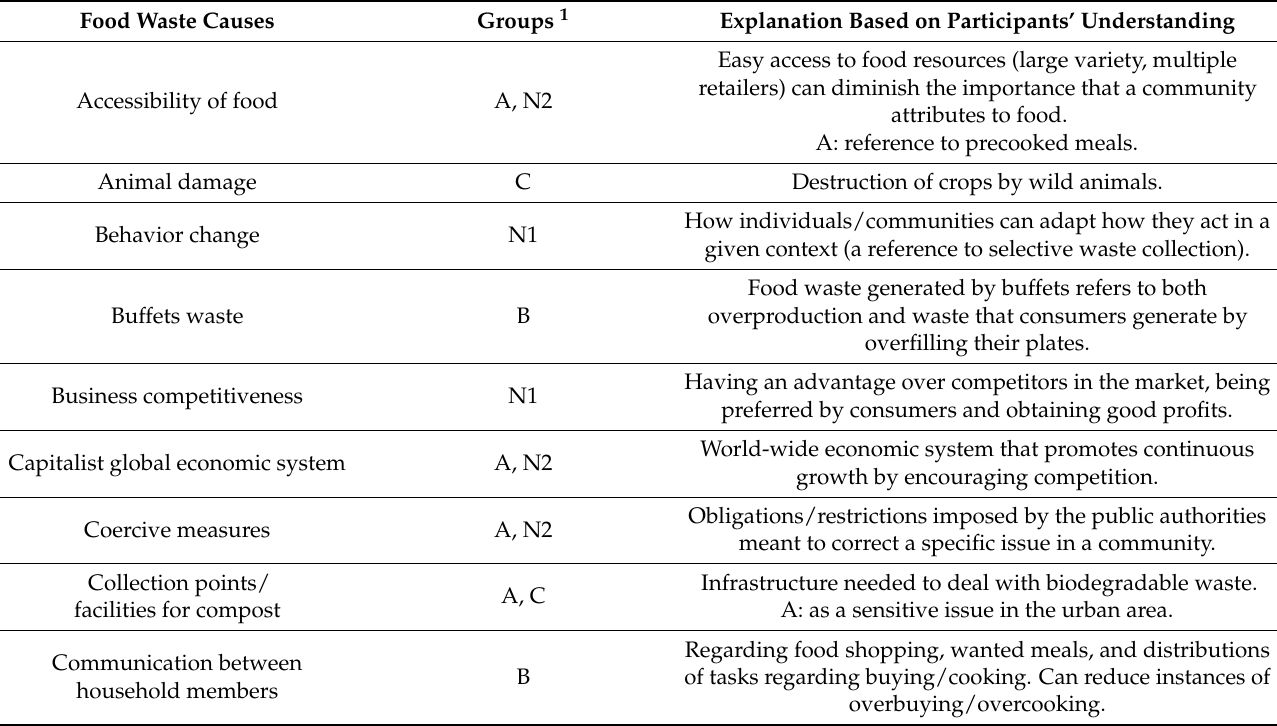
Table 1. List of variables discussed during the modeling